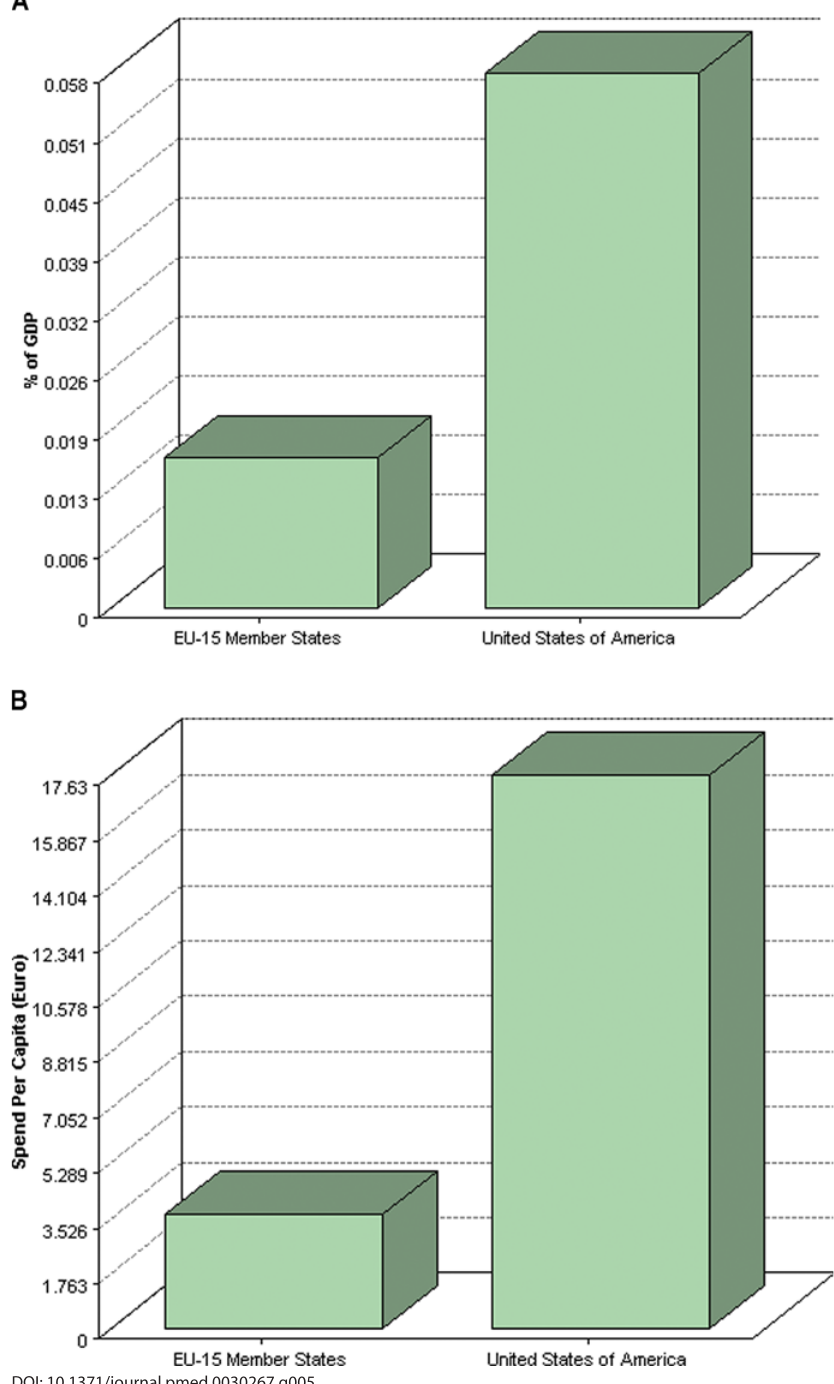
Figure 5. Comparison of Direct Cancer Research Spending between EU-15 Only and the US, as a Percentage of GDP and as Spending per